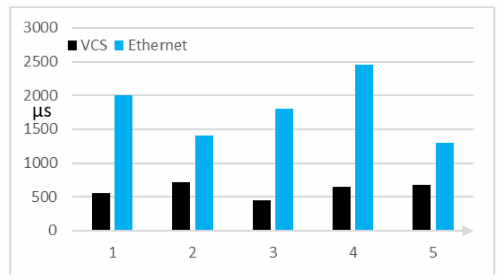
Figure 14. Latency of parameter